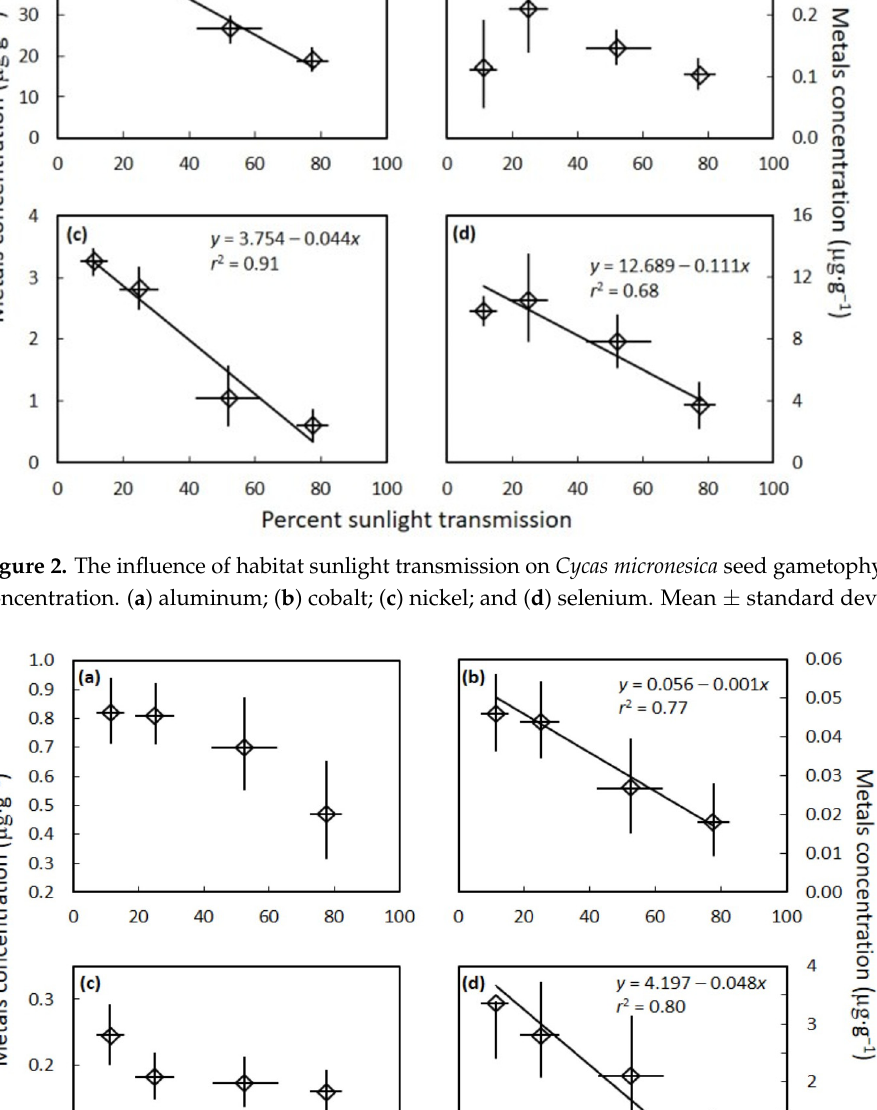
Figure 3. The influence of habitat sunlight transmission on Cycas micronesica seed gametophyte metal concentration. ( a ) arsenic; ( b ) cadmium; ( c ) chromium; and ( d ) lead. Mean ± standard devia- tion.